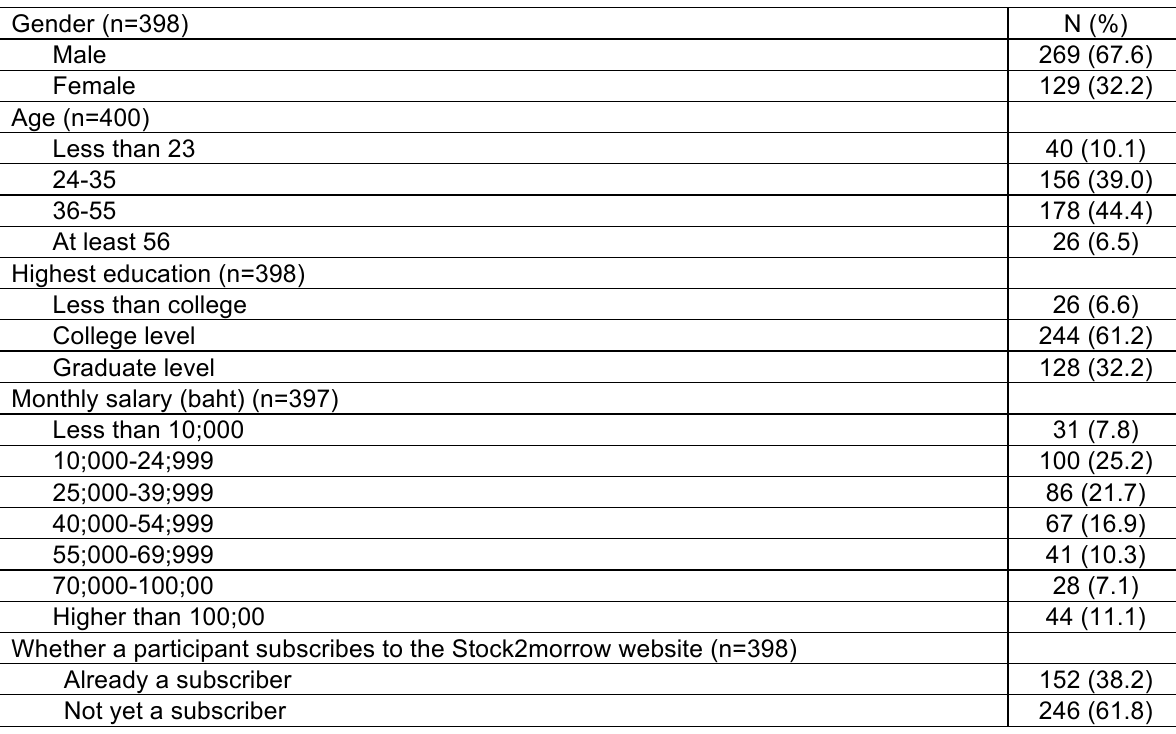
Table 1: Profiles of the participants